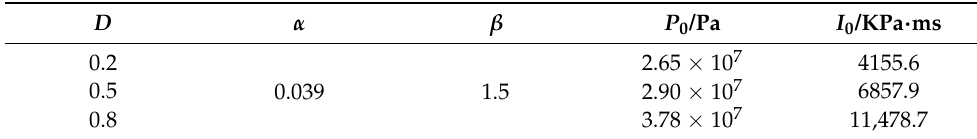
Table 4. Fitted parameter values of three P - I curves.